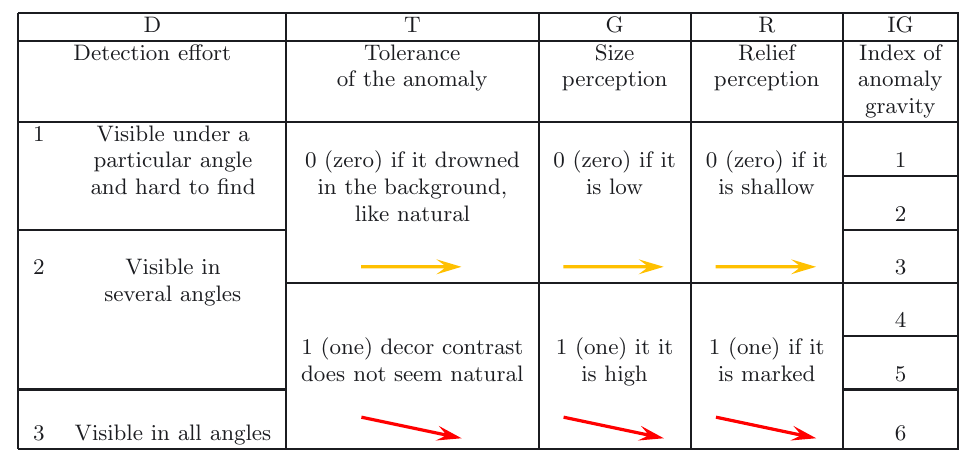
Table 4. Corrected hierarchical table.